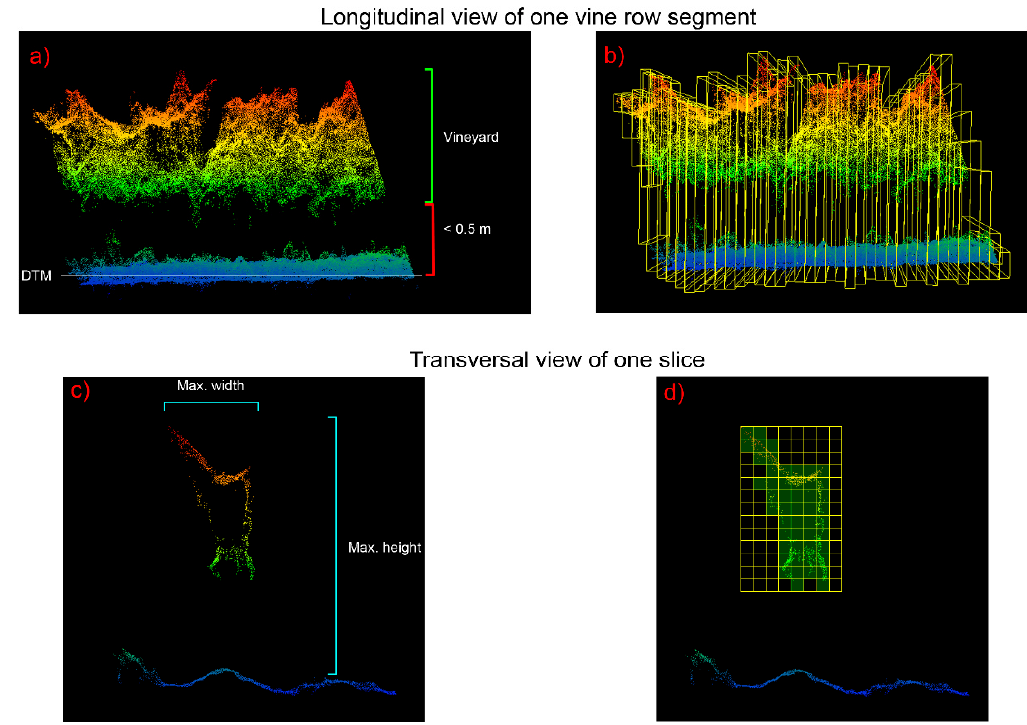
Figure 6. Graphical summary of the main steps of the Object Based Image Analysis (OBIA) algorithm for vineyard characterization. ( a ) Side view of the point cloud of one segment of vine row. The height threshold for vineyard classification is showed. ( b ) Boxes showing the slicing applied to the vine row. ( c ) Front view of one of the vine slices from 6b. ( d ) Division of the previous slice in